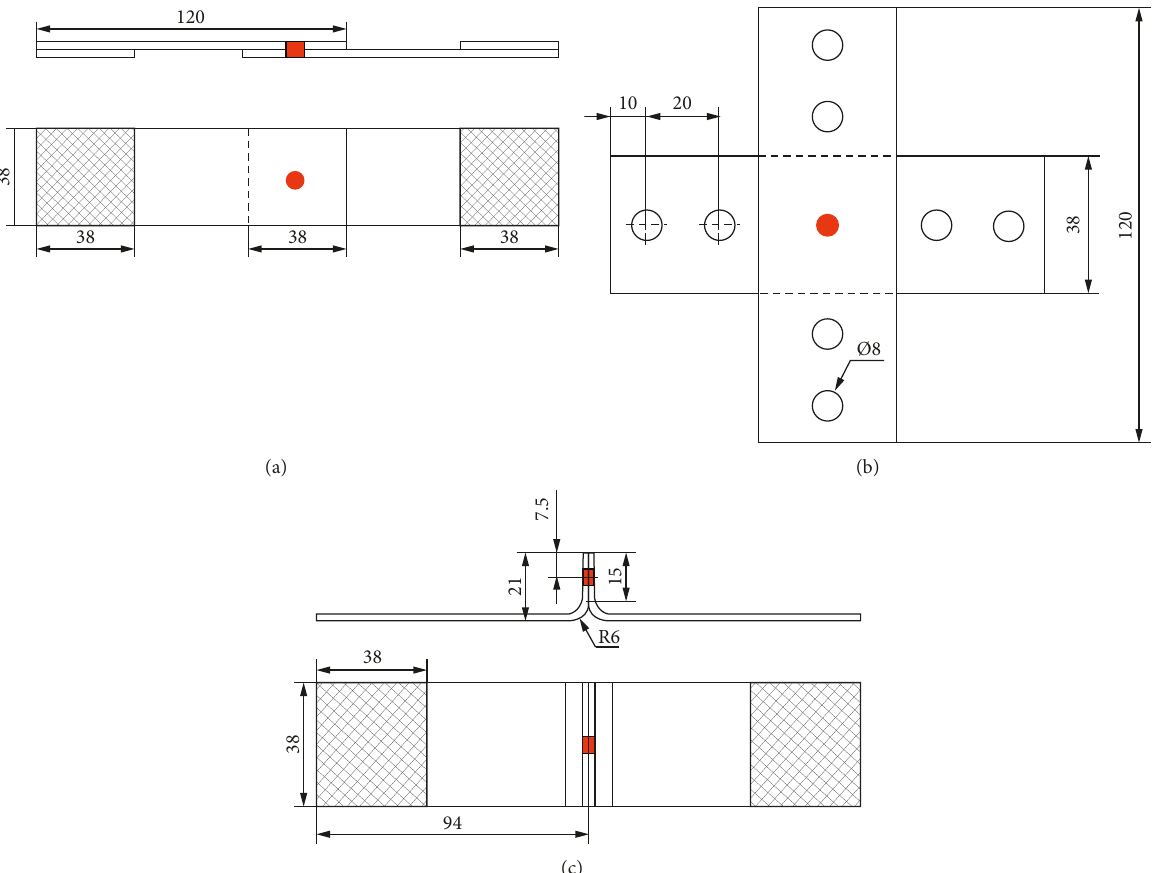
Figure 2: Specimens of joints for testing: (a) lap-shear, (b) cross-tension, and (c)